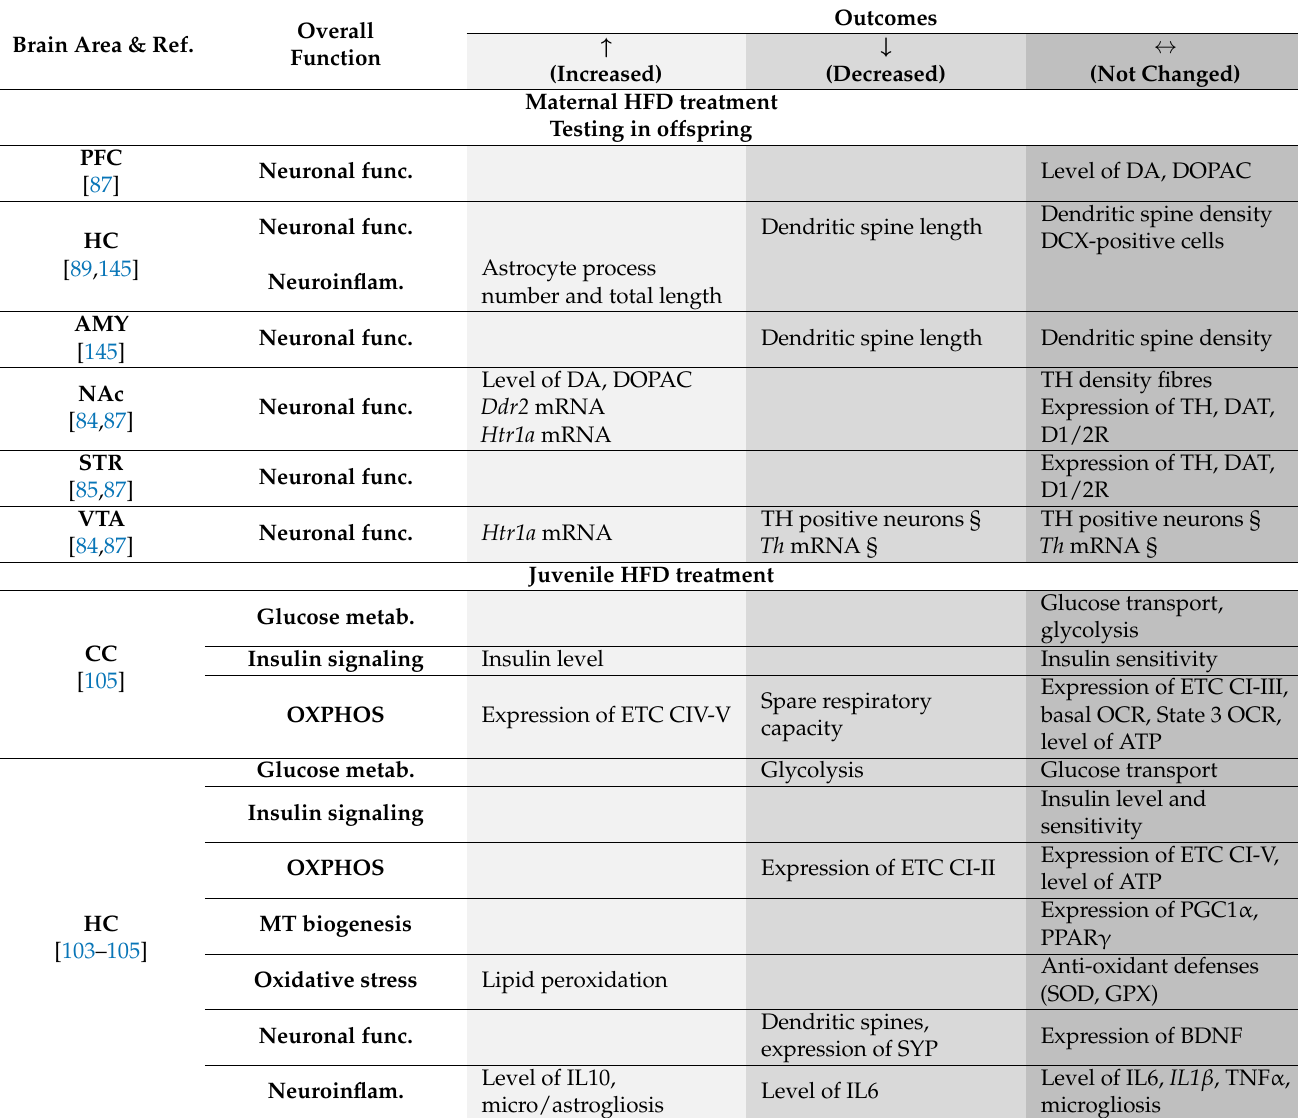
Table 2. Literature overview of the impact of a high-fat diet treatment on molecular correlates of energy metabolism and plasticity in the brain of rodents. Description: Studies are organized by period in which the high-fat diet (HFD) treatment was applied (i.e., before puberty, during adolescence or in adulthood). For the effects of a maternal HFD treatment, studies are organised by the developmental period (i.e., before puberty or early adolescence, during late adolescence or in adulthood) in which the offspring were tested. The numbered references refer to the bibliography